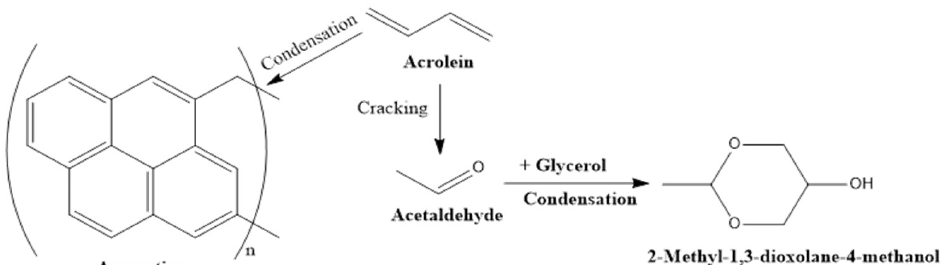
Figure 9. Possible reaction pathways for coke formation during catalytic dehydration of glycerol to produce acrolein [113]. Copyright 2021, Elsevier.